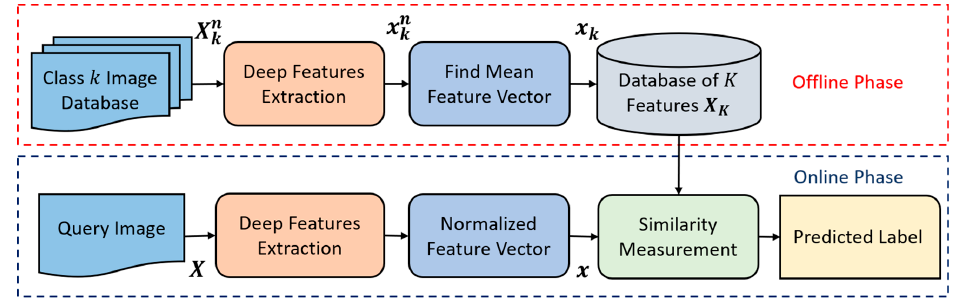
Figure 4. Proposed deep-feature-based variable node classification (VNC) framework.